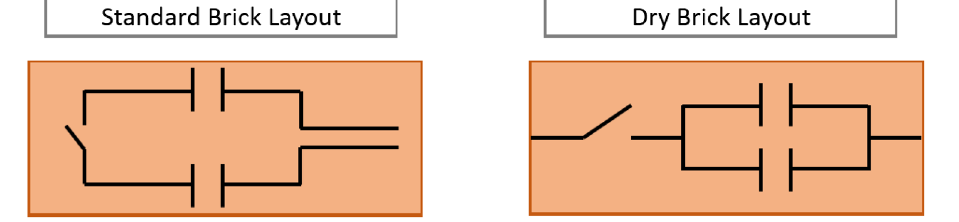
FIG. 1. Schematic layouts for “ standard ” and “ dry ” brick